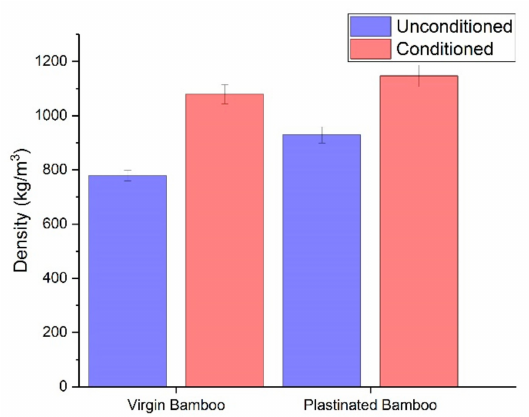
Figure 1. Density of virgin and plastinated bamboo, before and after moisture conditioning.